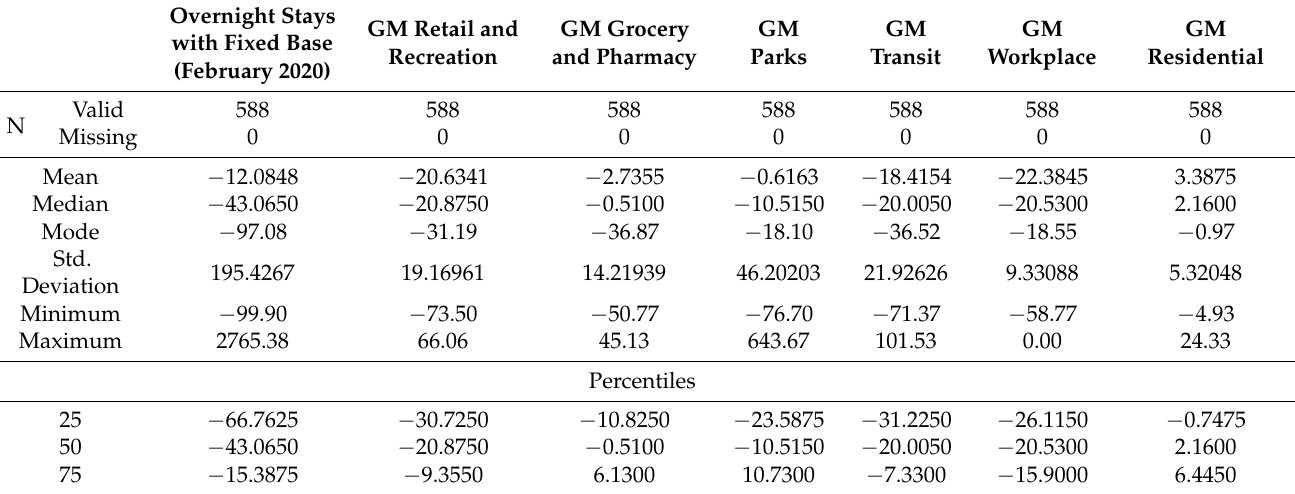
Table 2. Descriptive statistics for research